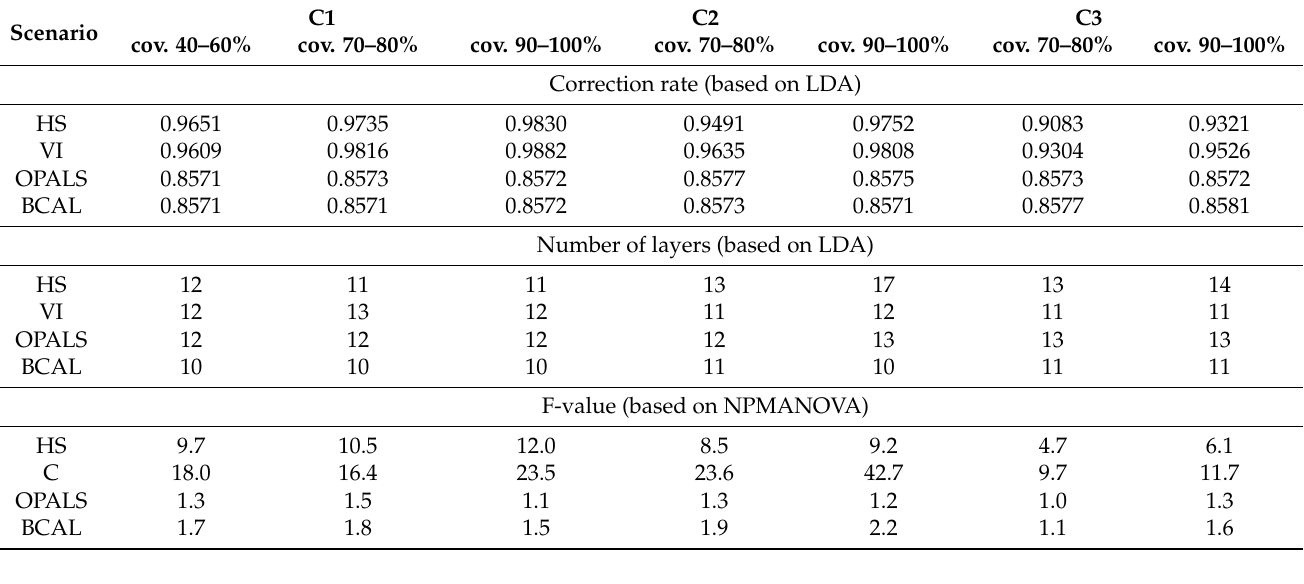
Table 3. The values of the average correction rate, number of layers defined as differentiating (the result of Linear Discriminate Analysis), and F value (the result of Non-Parametric Multivariate Analysis of Variance) for different datasets and three campaigns (C1, C2, C3) calculated based on 100 iterations.